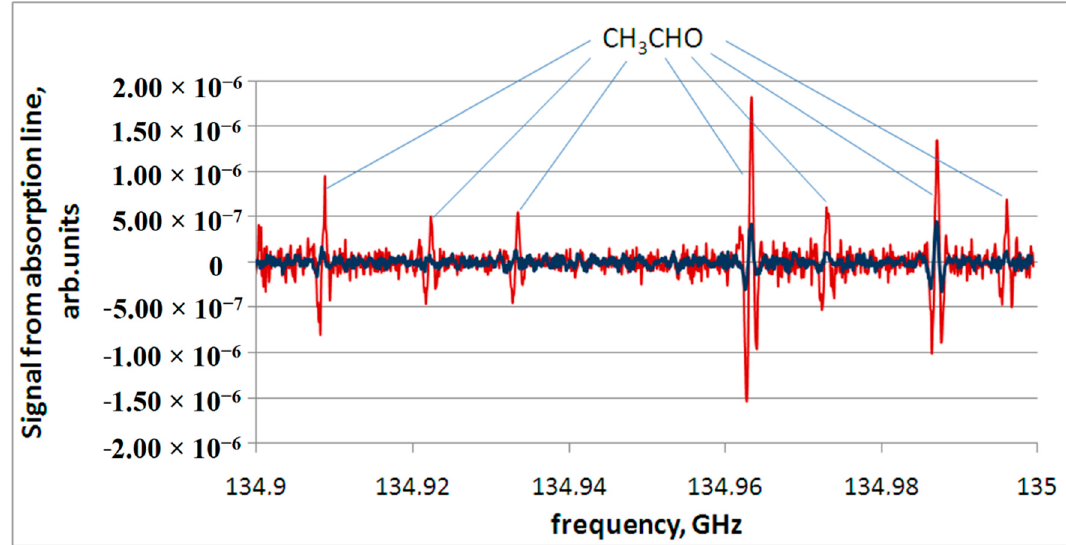
Figure 3. Example of recording a spectrum section containing acetaldehyde (CH 3 CHO) lines for Sample No. 2 (blue line) and Sample No.6 (red line) with experimentally measured central frequencies f 1exp = 134.9087 GHz (cf. with the frequency from on-line database f 11cat = 134.9084537 GHz for the transition with quantum numbers 7 4 4 0 ← 6 4 3 0 [15], f 12cat = 134.9086558 GHz for the transition with quantum numbers 7 4 3 0 ← 6 4 2 0 [15]), f 2exp = 134.9222 GHz (f 2cat = 134.9222164 GHz for the transition with quantum numbers 7 4 3 2 ← 6 4 2 2 [15]), f 3exp = 134.9334 GHz (f 3cat = 134.9333724 GHz for the